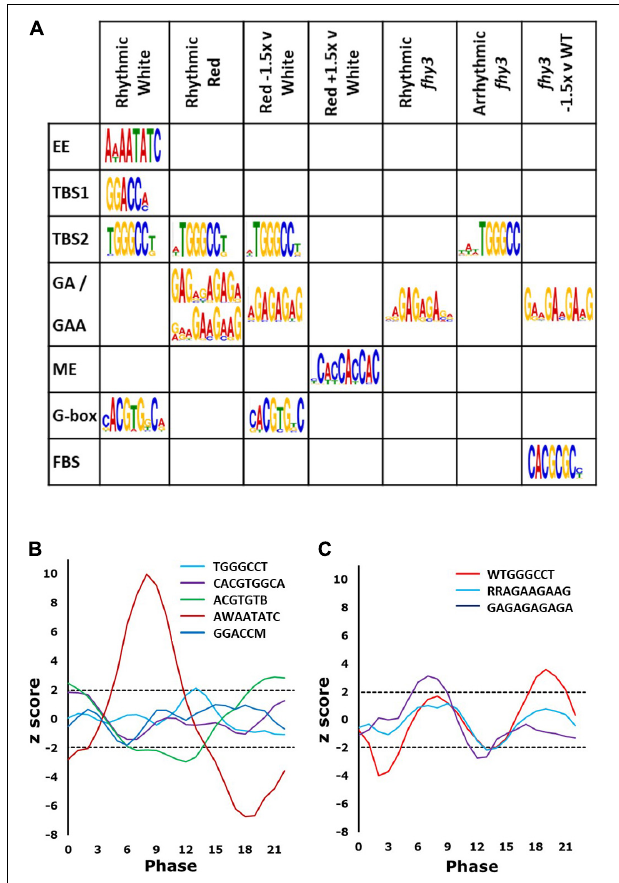
FIGURE 5 | Promoter elements enriched in rhythmic genes. (A) Recognised elements enriched in genes in the categories indicated. Rhythmic White (rhythmic in wild type in white light); Rhythmic Red (rhythmic in wild type in red light); Red –1.5x v White (rhythmic genes in white light showing mean expression in red light ≤ 1.5-fold that in white light); Red +1.5 v White (rhythmic genes in white light showing mean expression in red light ≥ 1.5-fold that in white light); Rhythmic fhy3 (genes which maintain rhythmicity in fhy3 in red light); Arrhythmic fhy3 (genes which lose rhythmicity in fhy3 in red light); fhy3 –1.5 v WT (genes with mean expression in fhy3 in red light ≤ 1.5-fold that in wild type in red light). (B) Phase enrichment among Rhythmic White genes containing the elements indicated. Note two variants of the G-box are shown. (C) Phase enrichment among the Rhythmic Red genes containing elements indicated. Phase enrichment is represented by z -score and plotted as a three-point moving average. Dotted lines indicate z -scores corresponding to p = 0.05. Z -scores greater than 1.96 or less than –1.96 indicate significant enrichment for a given